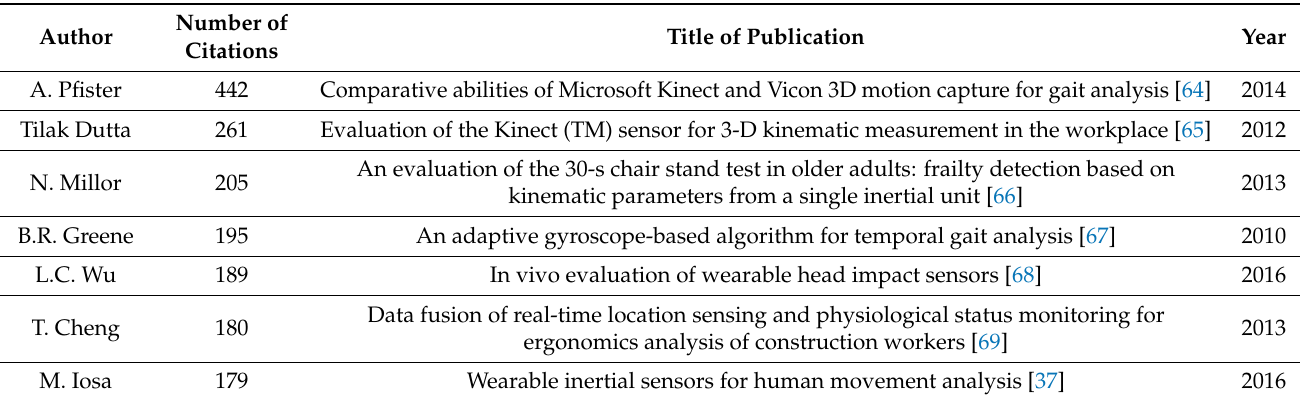
Figure 7. Number of national publications by country of authors ’ origin. Source: own processing.